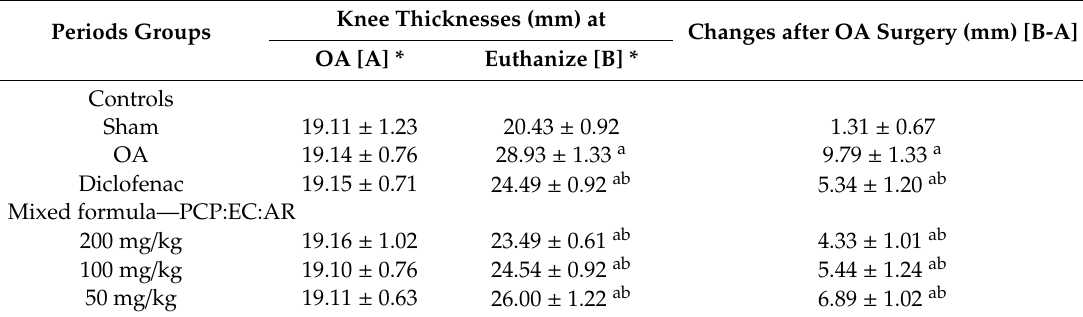
Table 2. Knee thickness changes in sham-operated or OA